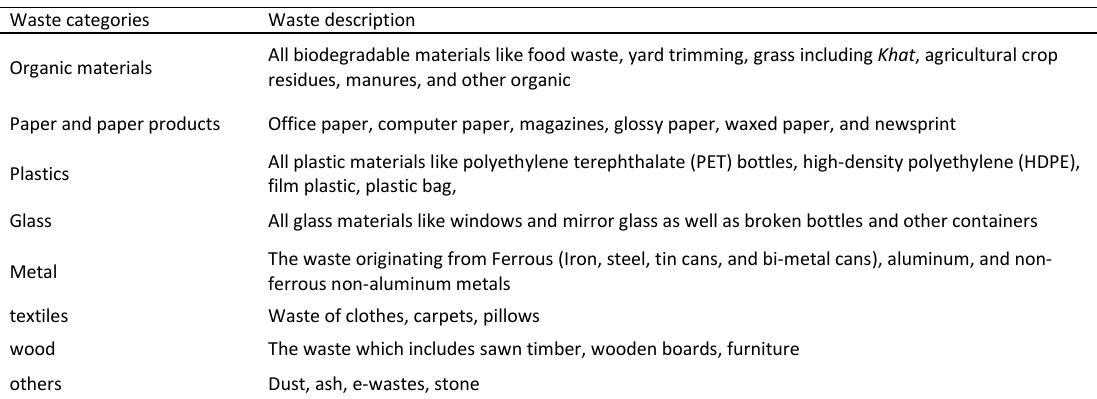
Table 1: Waste categories of MSW